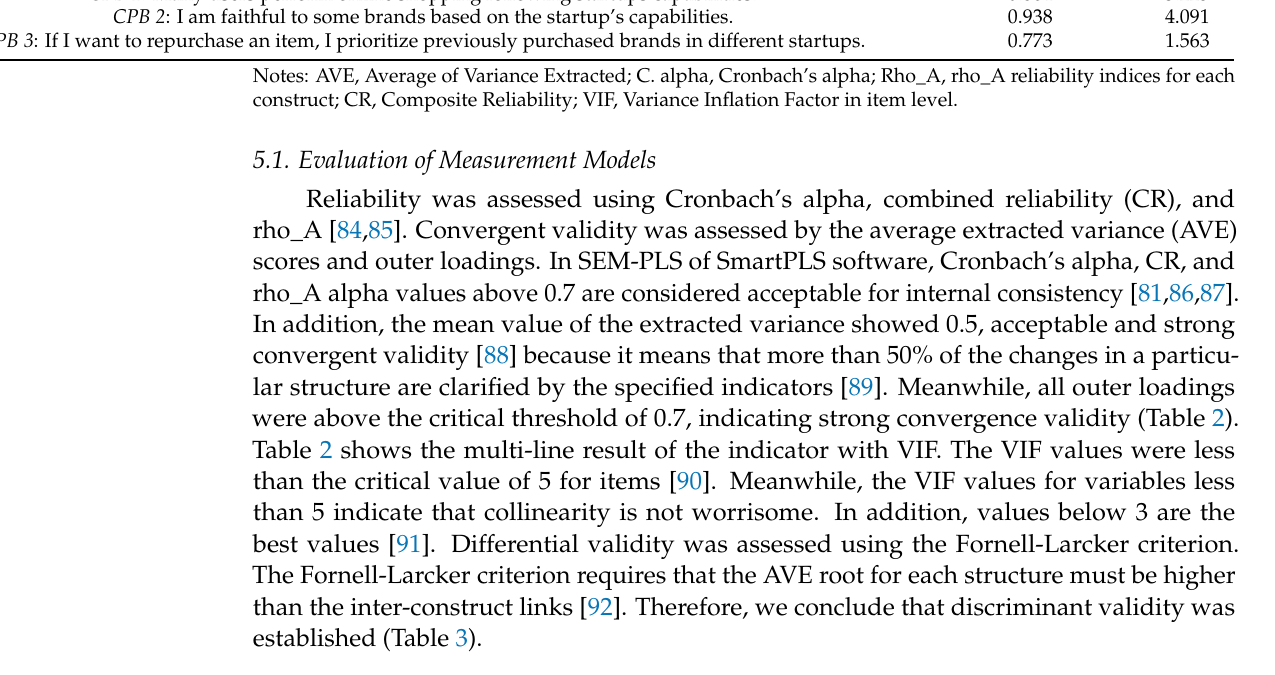
Table 3. Discriminant